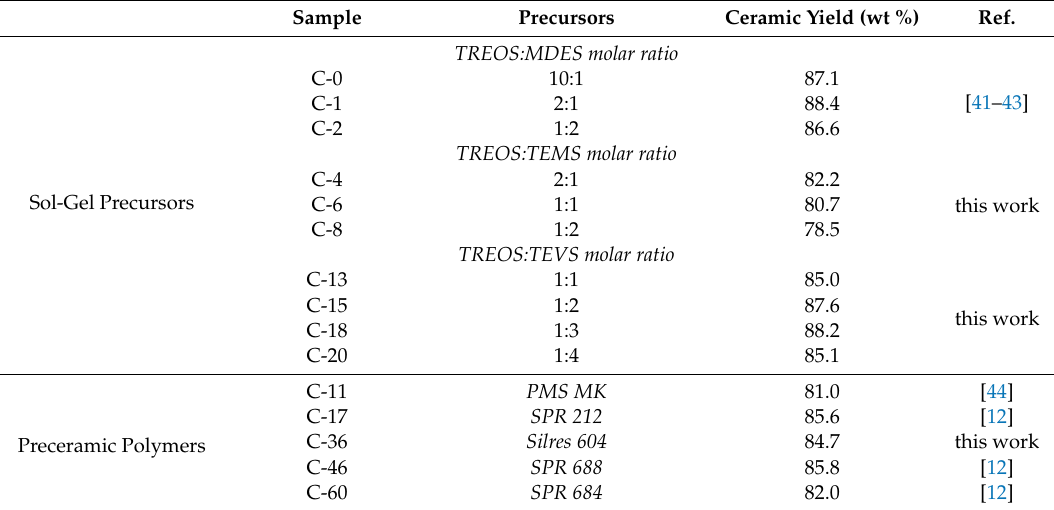
Table 1. SiOC / C-based samples considered in the present study. The number given in the sample name indicates the volume fraction of the segregated carbon